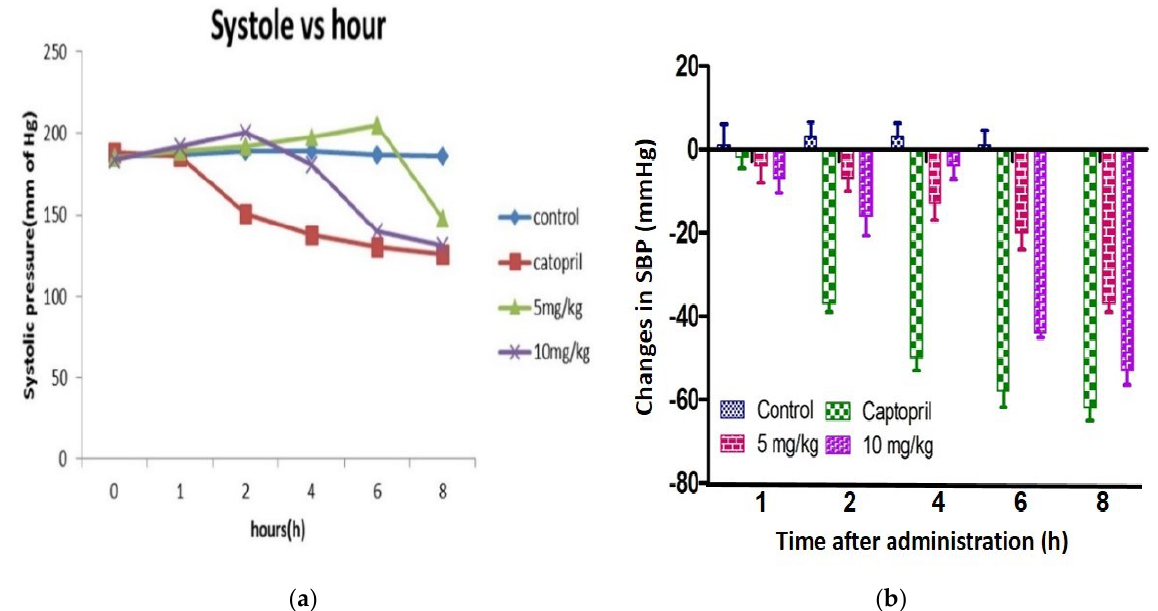
Figure 17. ( a , b ): Decrease in systolic blood pressure (SBP) in hypertensive rats.